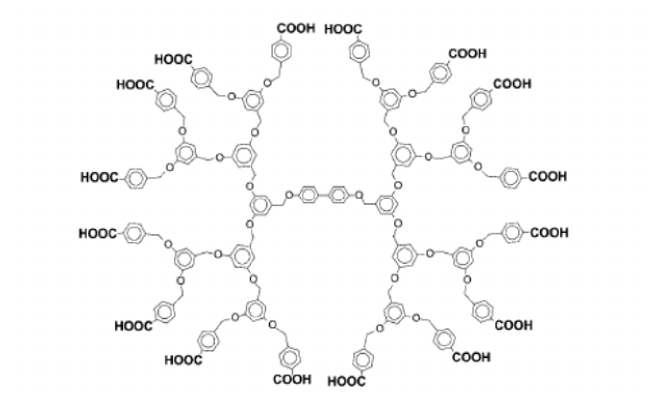
Figure 5. Chemical structure of carboxyl-terminated dendrimer (DEN-COOH). Reprinted